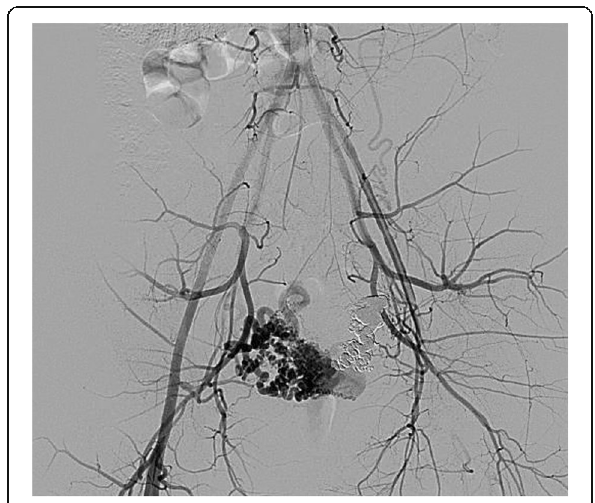
Fig. 8 Another case of a known arteriovenous fistula status post Onyx